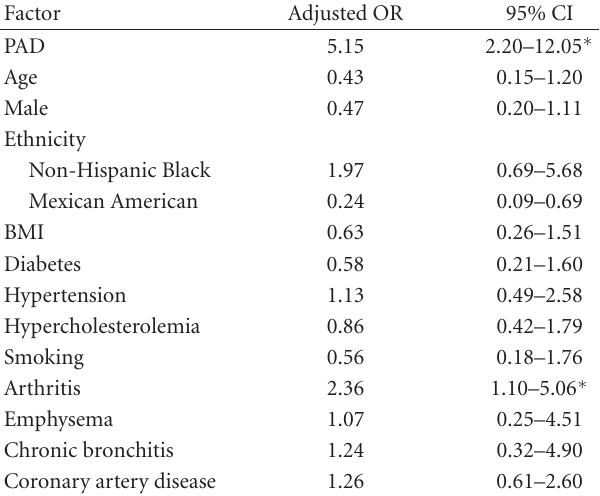
Table 3: Multivariate logistic regression analysis showing associa- tion between PAD and functional limitation in patients with CHF.